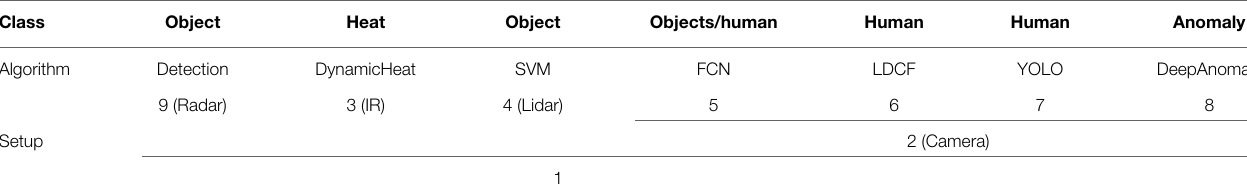
TABLE 3 | Listing of setups and the detection algorithms they comprise.